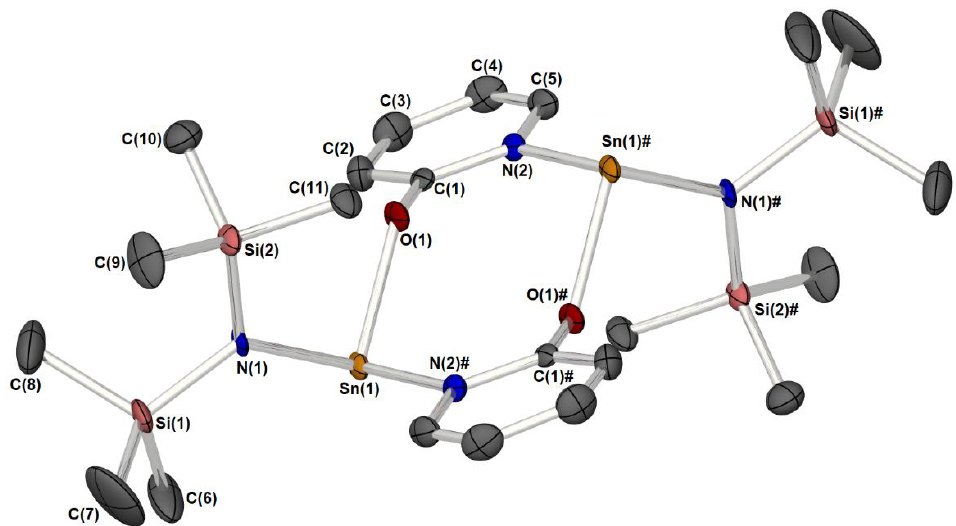
Figure 5. The molecular structure of one of the two full molecules of complex 1 present in the unit cell. Symmetry transformations (#) used to generate equivalent atoms; #: − X, − Y, 1 − Z. Thermal ellipsoids are shown at 50% probability. Hydrogen atoms have been omitted for clarity.